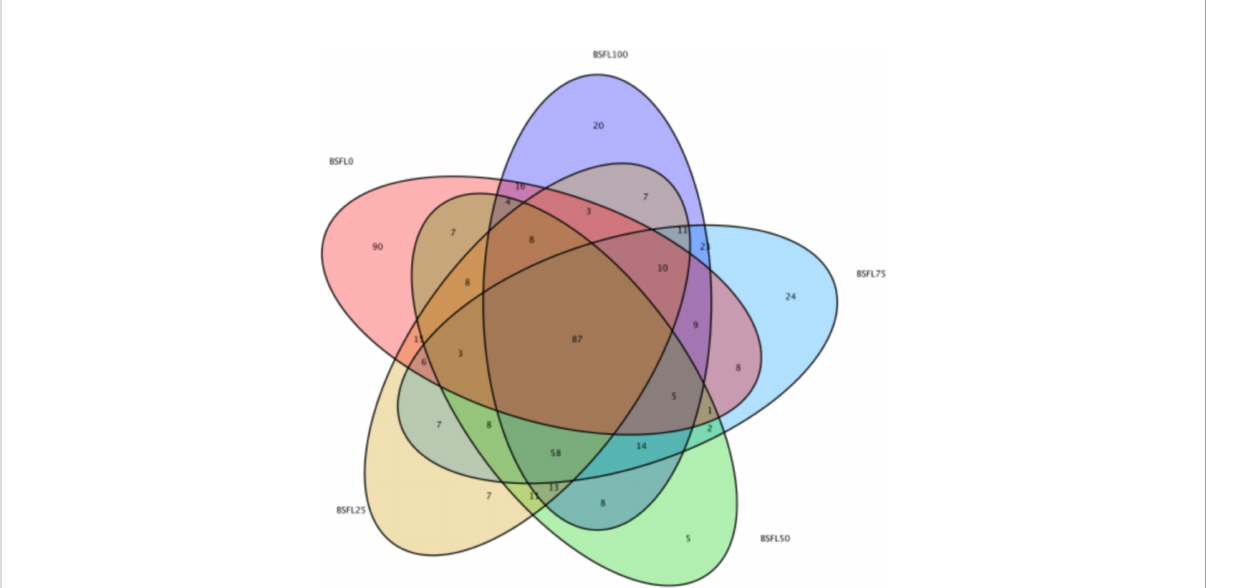
FIGURE 3 Venn diagram showing the distribution of all OTUs shared by L. vannamei in fi ve groups. The fi gures in the Venn diagram indicate the number of the sequences that are associated with the OTUs in each